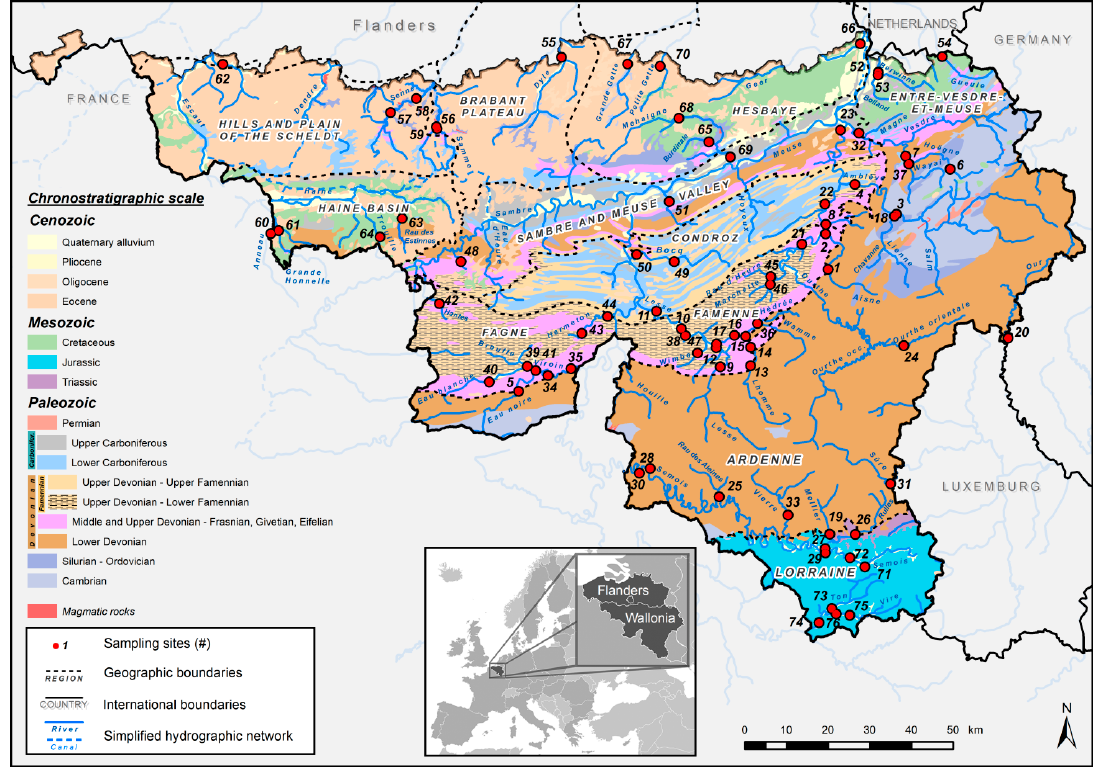
Figure 1. Location of the studied hydrological stations and simplified geological map of Wallonia (according to de Béthune [25] and Dejonghe [26], modified).